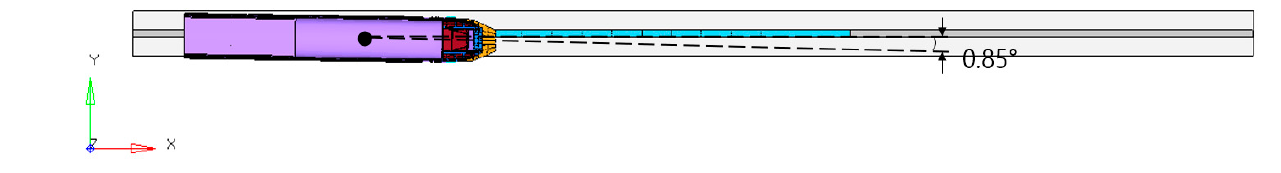
Figure 9. Condition of impact simulation.